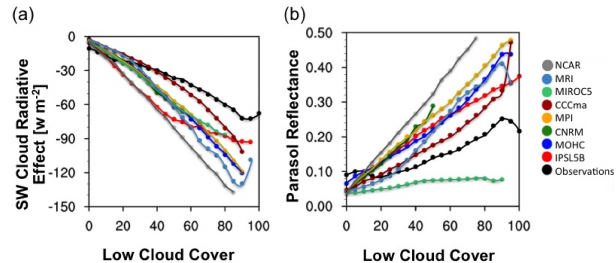
Figure 9. Mean relationship between non-overlapped low-cloud cover (%) and (a) the shortwave cloud radiative effect (W m − 2 ); and (b) the PARASOL reflectance, derived for observations and for CMIP5 models over the tropical oceans (30 ◦ N–30 ◦ S) from June 2006 to December 2008. Black: CERES and PARASOL observations, respectively; grey: NCAR; light blue: MRI; light green: MIROC5; light red: IPSL5B; dark blue: MOHC; dark green: CNRM; dark red: CCCma; orange: MPI. Redrawn with modifica- tion from Nam et al.